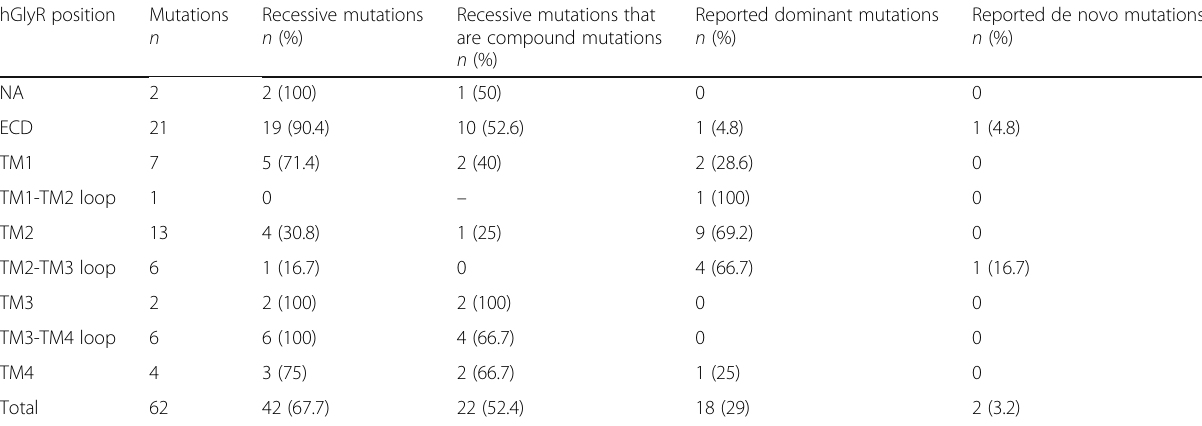
Table 2 Distribution of hyperekplexia mutations in GLRA1 according to the hGlyR position hGlyR position